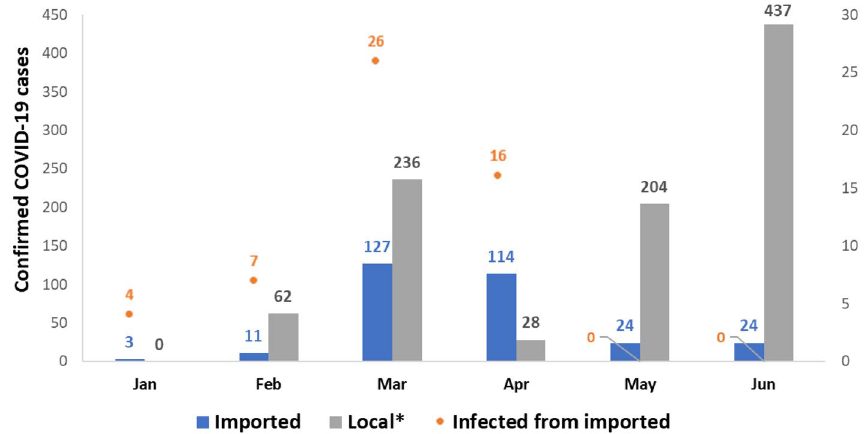
Figure 1. Imported, local COVID-19 cases and secondary cases from imported cases in Seoul, Korea (reconstructed based on the estimated infection source of the confirmed